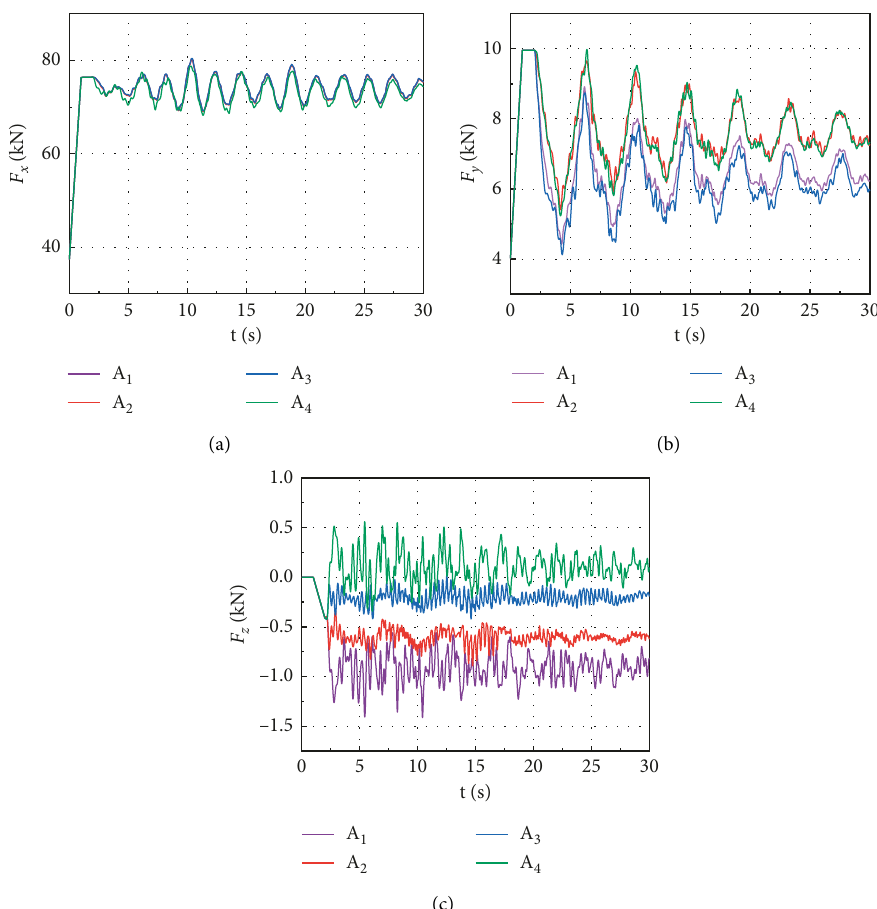
Figure 22: Conductor tension applied on tension string: (a) Fx, (b) Fy , (c) Fz